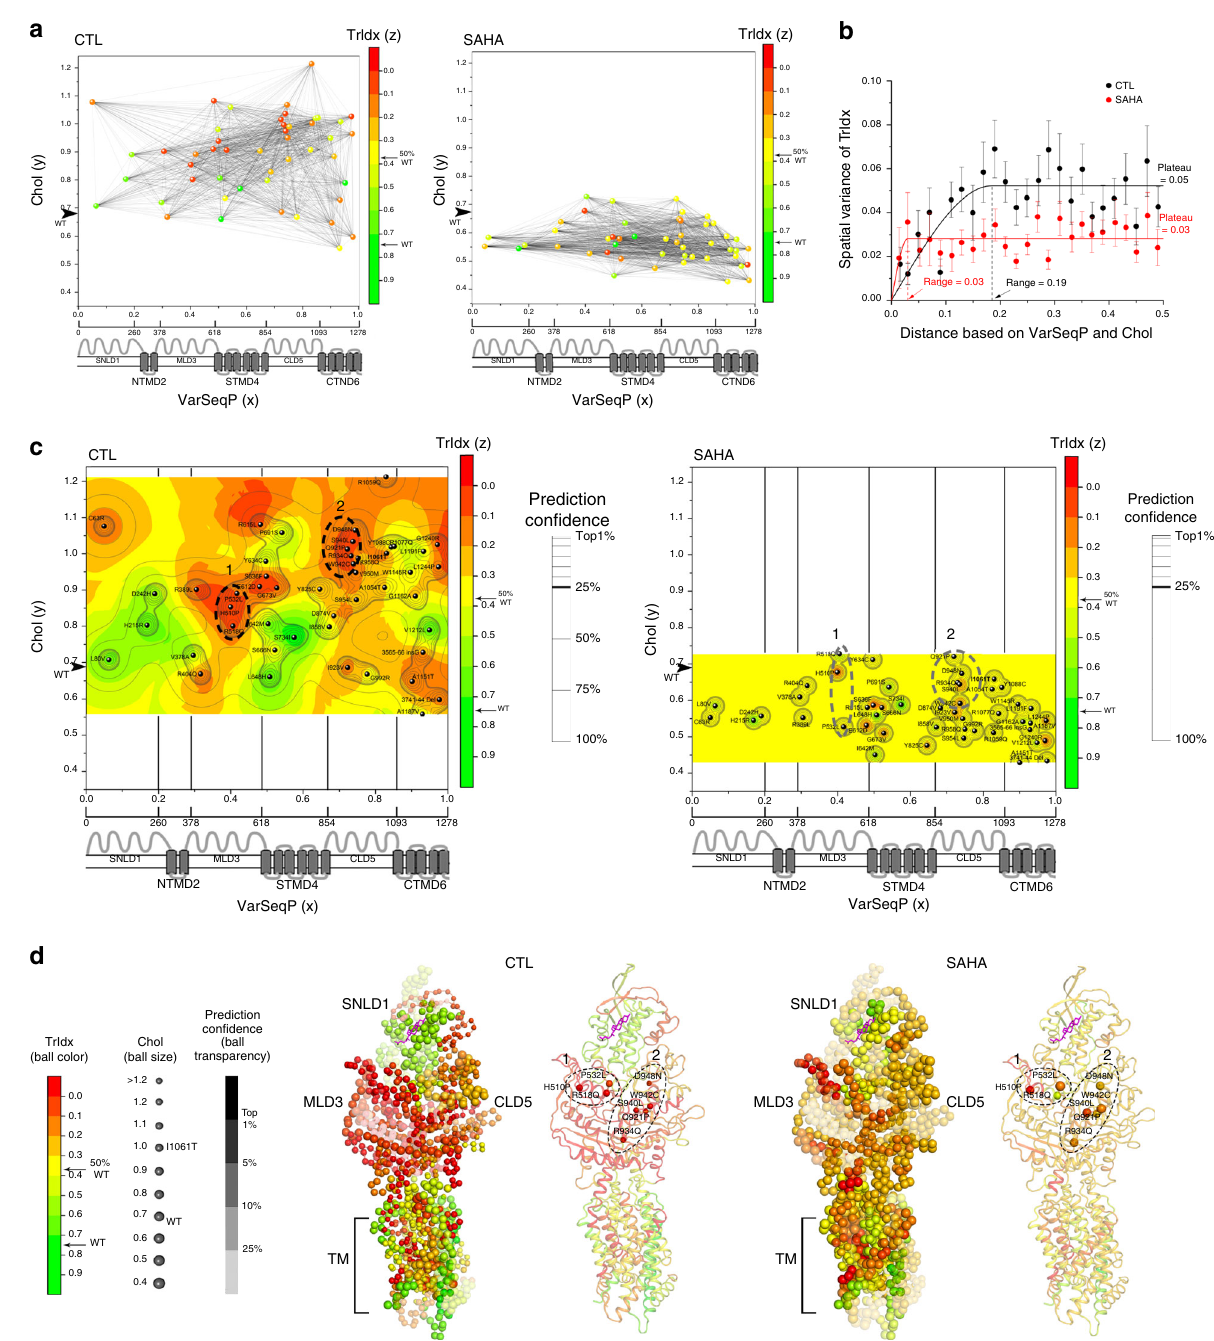
Fig. 2 TrIdx-phenotype landscape and TrIdx-structure in the absence and presence of SAHA. a NPC1 variants are positioned by their variant sequence position (VarSeqP) ( x -axis) normalized to the full-length sequence and measured Chol values of NPC1 variants ( y -axis normalized to I1061T) in the absence (left panel) or presence (right panel) of SAHA. The projected z -axis (color gradient) is de fi ned by the absolute measured TrIdx of each variant. The spatial relationships of pairwise comparisons of variants are illustrated as black lines. b The molecular variogram illustrating the spatial variance of measured TrIdx for distance values de fi ned by VarSeqP and Chol in the absence (black line) or presence (red line) of SAHA (see Methods; Supplementary Fig. 6a). c VSP predicted TrIdx-phenotype landscape is shown as a heatmap in the absence (left panel) or presence (right panel) of SAHA. Con fi dence relationships (see Supplementary Fig. 6b) within the molecular variogram range are plotted as contour lines and the top 25% con fi dence quartile is shown as a bold line. Color-scale values: defective traf fi cking (red); ~50% WT traf fi cking (yellow); WT traf fi cking (green). I1061T ER-restricted variant is bolded. Dashed ovals 1 and 2 highlight two SCV clusters found in the top 25% con fi dence quartiles that have defective traf fi cking in the absence of SAHA. d Mapping the TrIdx-phenotype landscape on the NPC1 structure 25,29 . The highest con fi dent prediction of the TrIdx value and the corresponding Chol value is assigned for each residue with ball color representing TrIdx, ball size representing Chol, and transparency representing prediction con fi dence. SCV cluster 1 and 2 are selectively highlighted as balls in cartoon presentation of the structure